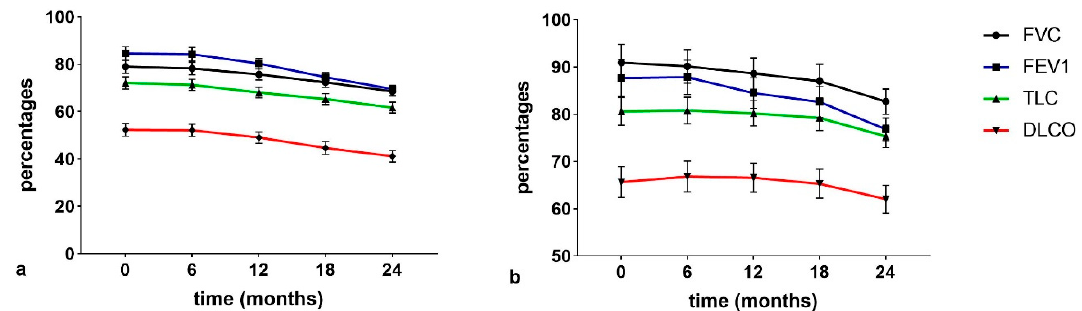
Figure 6. ( a ) IPF serial changes of pulmonary function test (PFT) parameters ( b ) non-IPF serial changes PFT parameters. The trend of functional parameters in the IPF population showed a progressive statis- tically significant decline at t3 and t4 ( p < 0.05). Due to the limited statistical sample, no correlations between serological biomarkers and survival data could be detected. Correla-